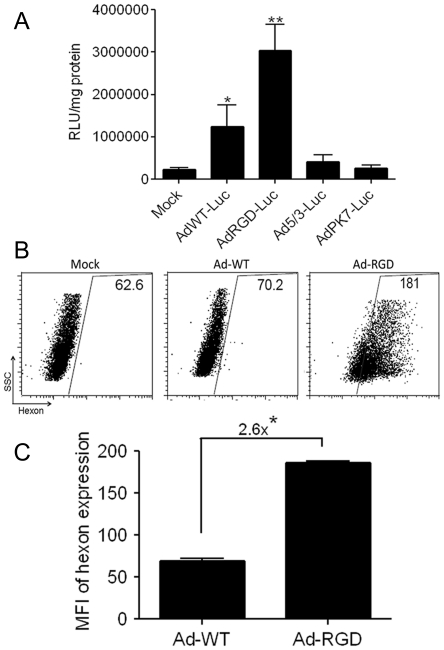
Primary murine CD8+ T cells can be transduced with RGD-modified adenovirus.(A) Primary mouse T cells were treated for 48 h with replication-deficient fiber-modified adenoviruses encoding luciferase gene. Luciferase activity was measured from lysates of treated cells and is represented as relative luciferase unit (RLU) per milligram of cell protein. Cells transduced with RGD-modified adenovirus (AdRGD-Luc) showed maximum luciferase activity. (*p<0.05) (**p<0.001). (B) Flow cytometric dot-plots showing mean fluorescence intensity of viral hexon proteins expressed by transduced T cells. Gates were drawn by excluding the mock-transduced cells (Mock) represented in the left panel. T cells that were transduced with oncolytic replication-competent adenovirus with wild type fibers (Ad-WT) are represented in the middle panel while cells transduced with RGD-fiber modified oncolytic adenovirus (Ad-RGD) are shown in right panel. (C) Bar diagrammatic representation of viral hexon MFI in adenovirus induced murine T cells. Ad-RGD transduced T cells expressed 2.6-fold more viral hexon proteins in comparison to Ad-WT transduced cells (*p<0.01). Error bars indicate mean ± SD.